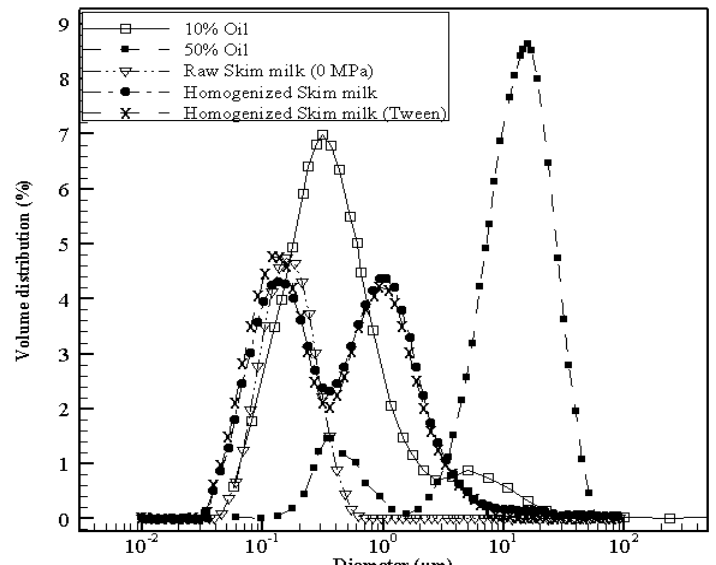
Figure 5: Effect of oil concentration (10% and 50%) on O/W emulsion homogenized at 150 MPa and skim milk (raw, homogenized and homogenized with Tween at 34.5 MPa) on their droplet size distribution [11, 25].